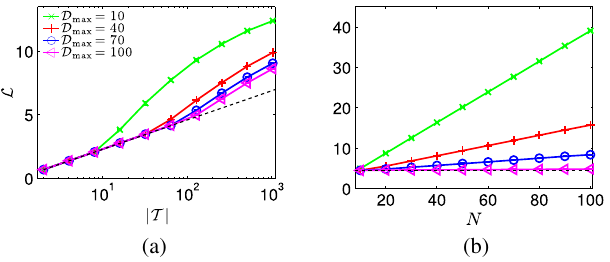
FIG. 2. NLL averaged as a function of (a) number of random patterns used for training, with system size N ¼ 20 . (b) System size N , trained using j T j ¼ 100 random patterns. In both (a) and (b), different symbols correspond to different values of maximal bond dimension D . Each data point is averaged over 10 max random instances (i.e., sets of random patterns); error bars are also plotted, although they are much smaller than symbol size. The black dashed lines in figures denote L ¼ ln j T j